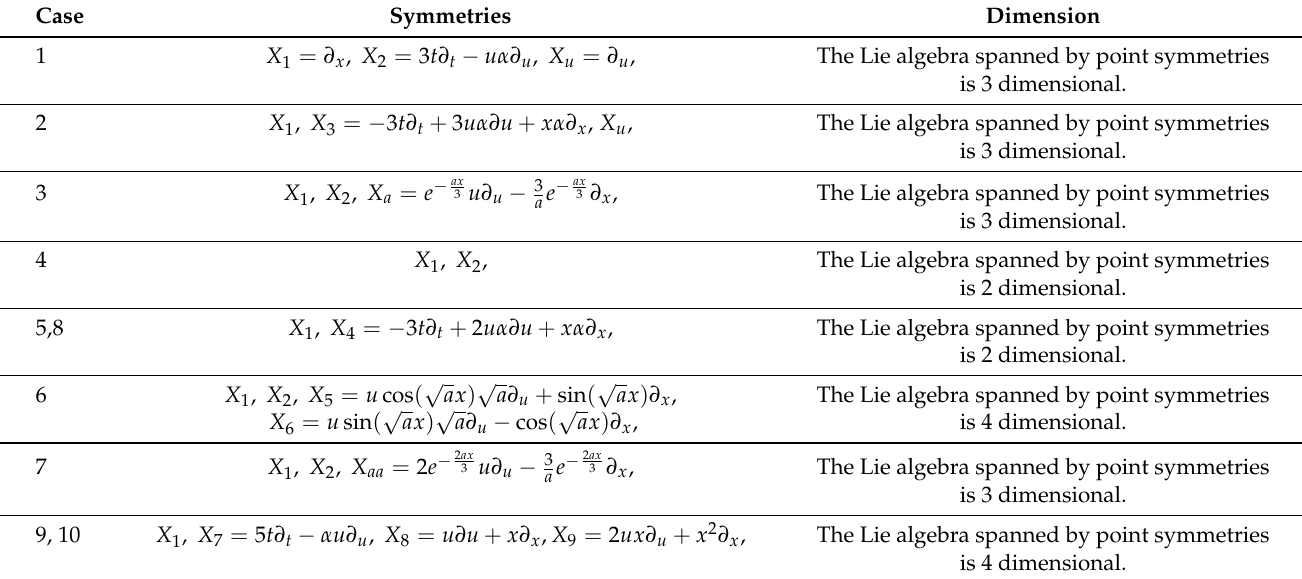
Table 1. Lie point symmetries of Equations